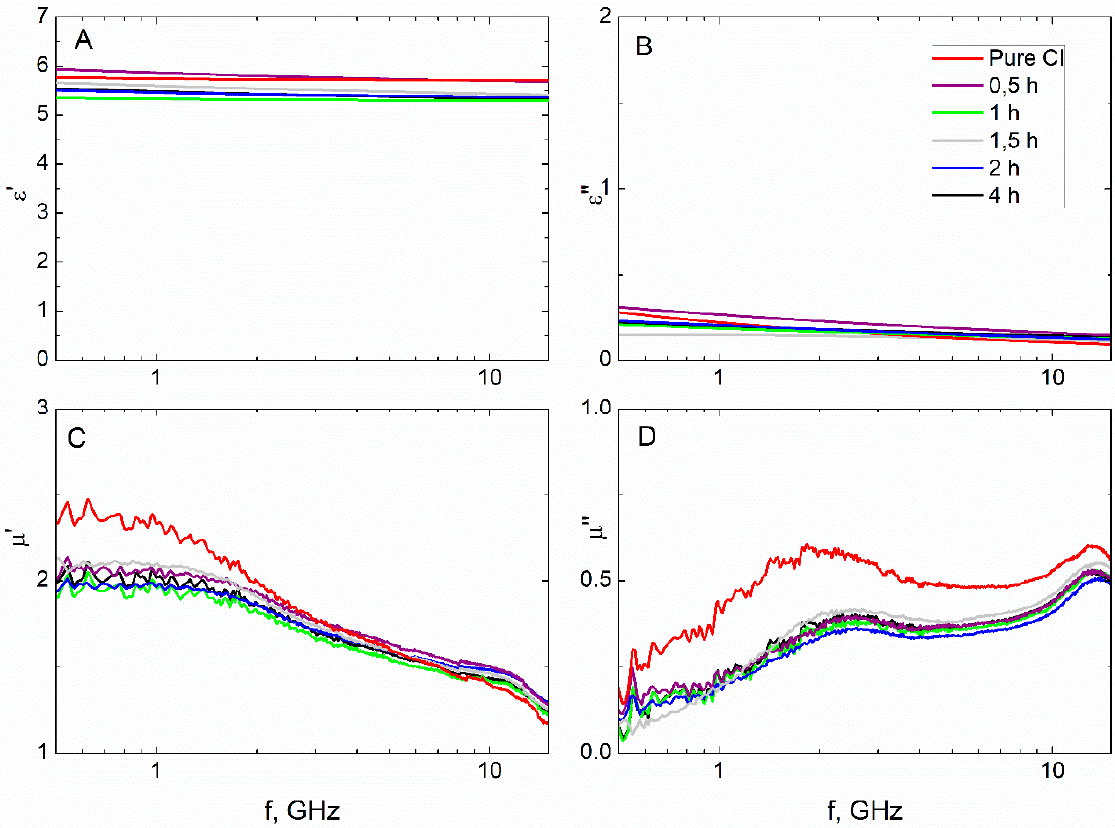
Figure 12. The measured frequency dispersions of complex permittivity, ε ′ ( A ) + i· ε ″ ( C ), and permeability, μ ′ ( B ) + μ ″ ( D ) for the Fe@SiO 2 –paraffin wax composite. The thickness of the shell of the Fe@SiO 2 filler varied through hydrolysis duration .